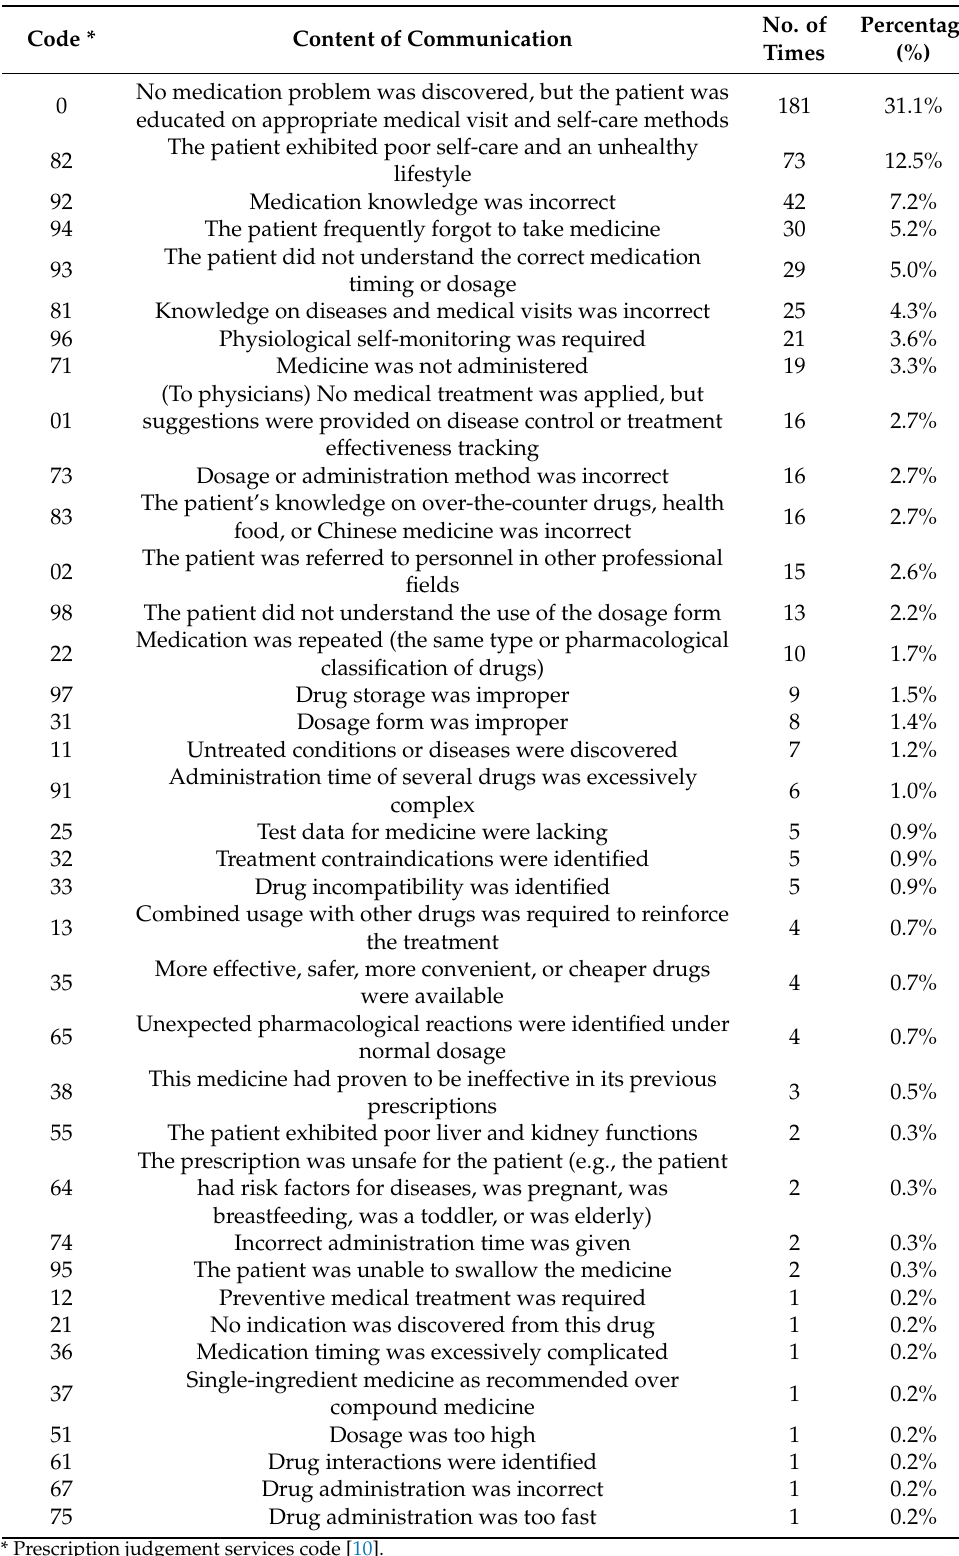
Table 2. Medication problems discovered by the pharmacists in the home medical care services ( N =